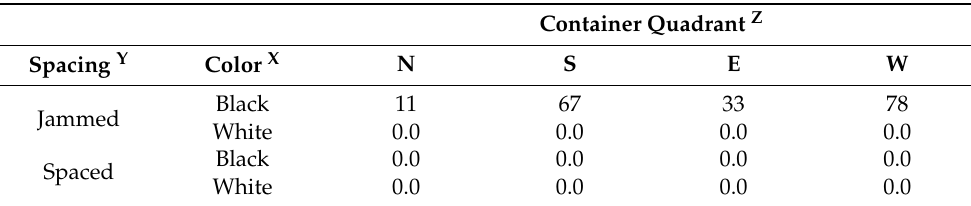
Table 3. Frequency (%) of ‘Soft Touch’ Japanese holly plants exhibiting severe root death on root ball surface ( n = 9). Container Quadrant Z Spacing Y Color X N S E W Black 11 67